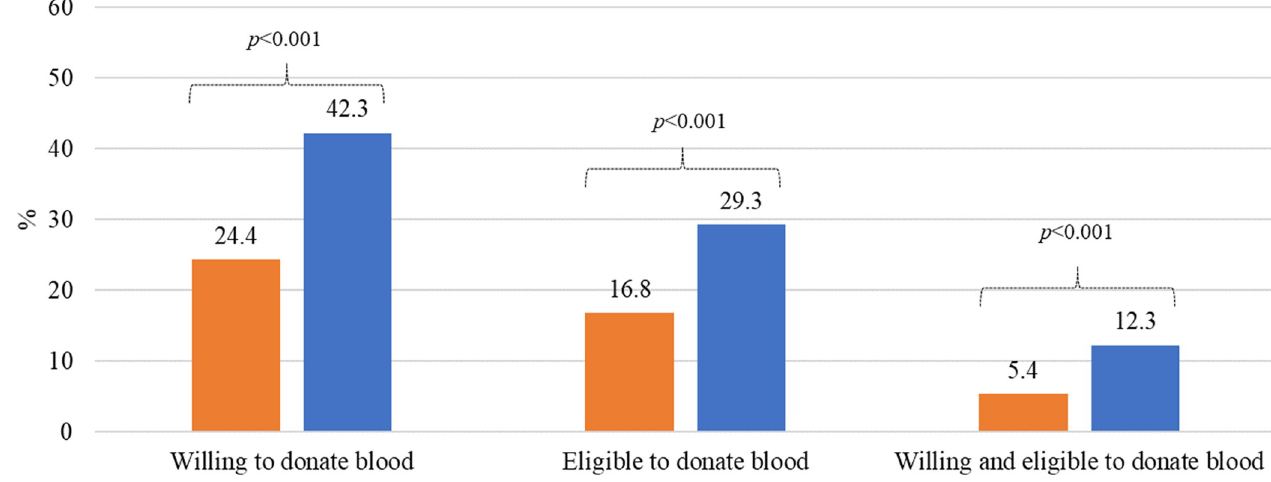
Fig 1. Willingness and eligibility to donate blood under 12-month and 3-month deferral policies (N = 447). Orange bar: 12-month deferral policy; Blue bar: 3-month deferral policy. Note : Reported p-values are from McNemar chi-square test for paired categorical